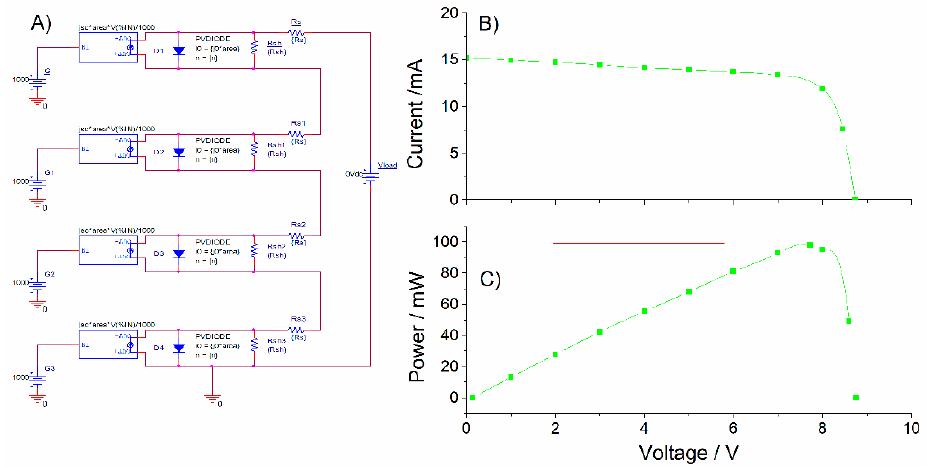
Figure 7. ( A ) Equivalent circuit used for a 4-cell string (serially-connected) organic solar module. ( B ) Generated I–V curves for standard irradiance STC 1000 Wm − 2 . ( C ) Power–voltage curve identifying the maximum power point.